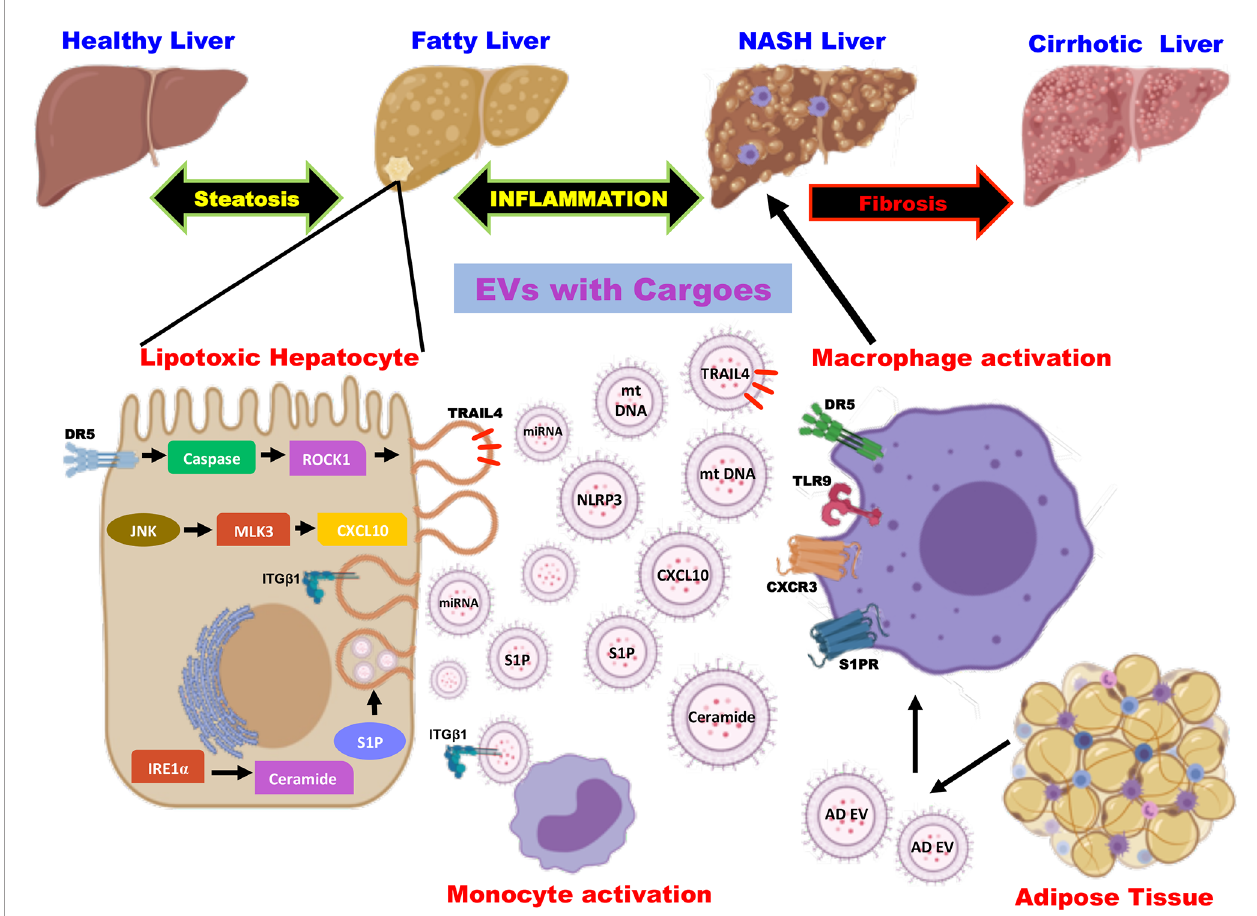
FIGURE 1 | Role of extracellular vesicles as drivers of in fl ammation in NAFLD. EVs are released from hepatocytes and adipose tissue upon lipotoxic insult and carry cargoes including proteins, lipids, miRNA, and mt DNA. EV cargoes act on the target cells and evoke an in fl ammatory response by the activation of monocytes and macrophages via distinct signaling pathways. EV, extracellular vesicles; miRNA, micro ribonucleic acid; mt DNA, mitochondrial deoxyribonucleic acid; DR5, death receptor 5; ROCK1, rho-associated containing protein kinase 1; JNK, c-Jun N-terminal kinase; MLK3, mixed lineage kinase 3; CXCL10, C-X-C motif ligand 10; IRE1 a , inositol-requiring protein-1 a ; S1P, sphingosine-1-phosphate; TRAIL4, tumor necrosis factor-related apoptosis-inducing ligand 4; NLRP3, nucleotide-binding oligomerization domain-like receptor protein 3; integrin b 1 (ITG b 1); AD EV, adipocyte-derived extracellular vesicles; TLR9, toll-like receptor 9; CXCR3, C-X-C motif receptor